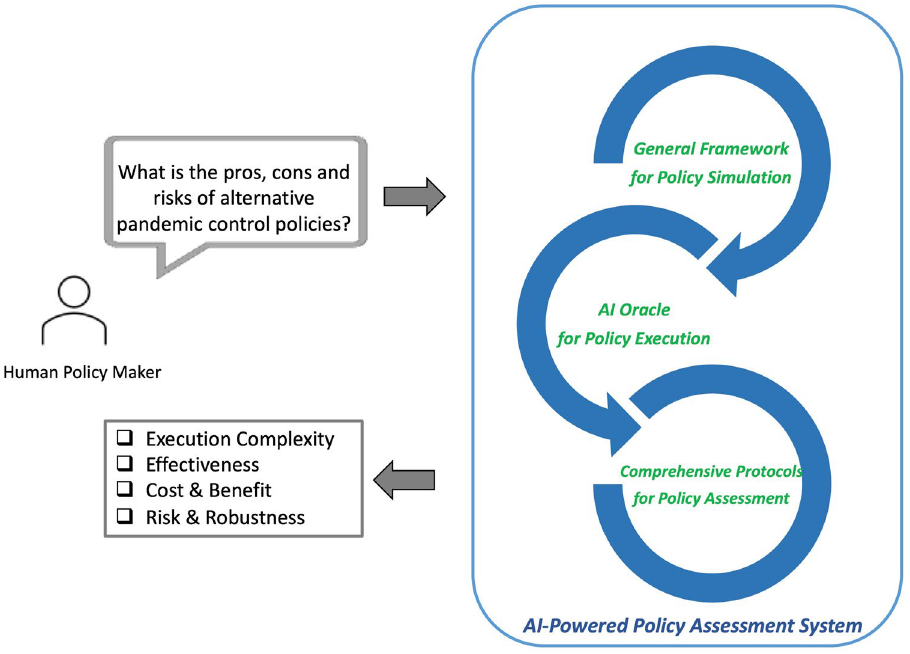
Figure 1. Workflow and components of the proposed AI-powered policy assessment